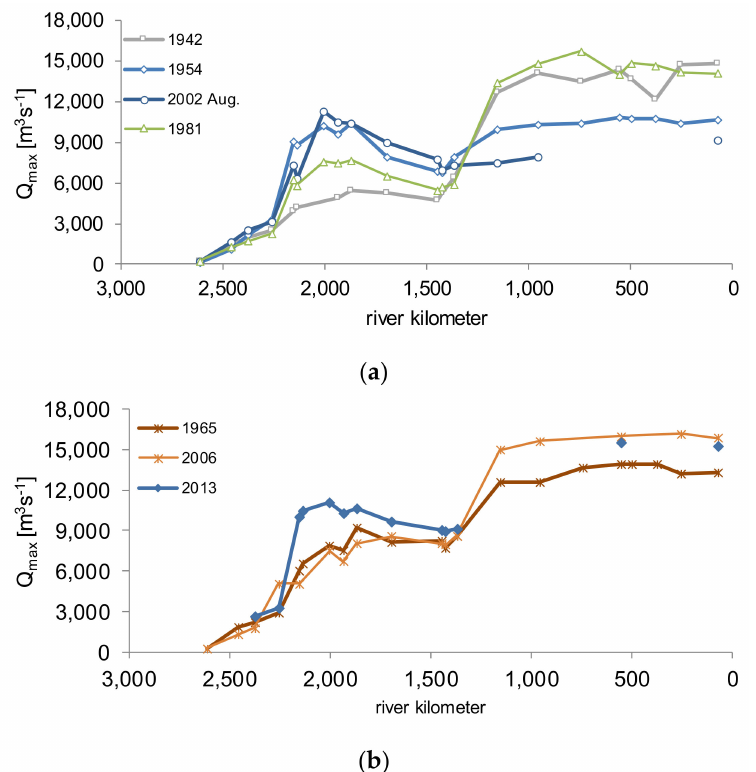
Figure 3. Course of various extreme floods along the Danube River: ( a ) floods in 1954, August 2002 on the upper Danube and floods in 1942, 1981 on the lower Danube; ( b ) floods in 1965, 2006 and 2013 along the entire length of the Danube